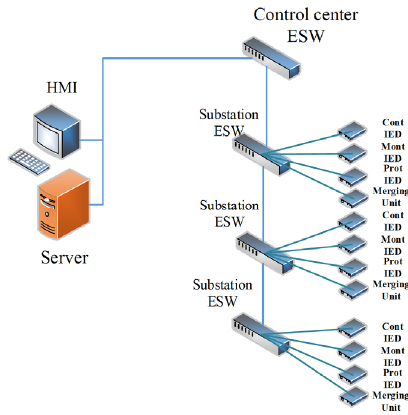
Figure 2. A typical cascading topology of the cyber layer.